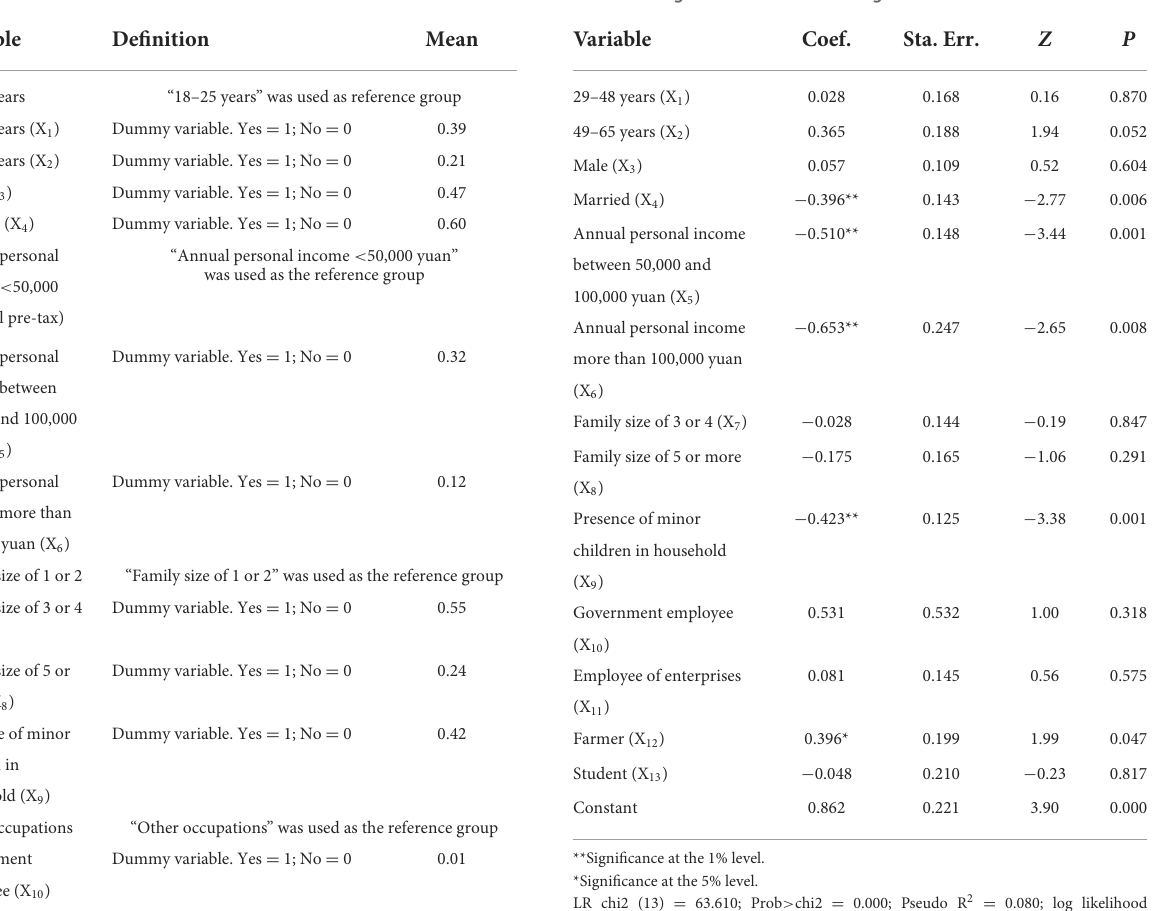
TABLE 3 Definition and measurement of variables. TABLE 4 Negative binomial count regression model estimation